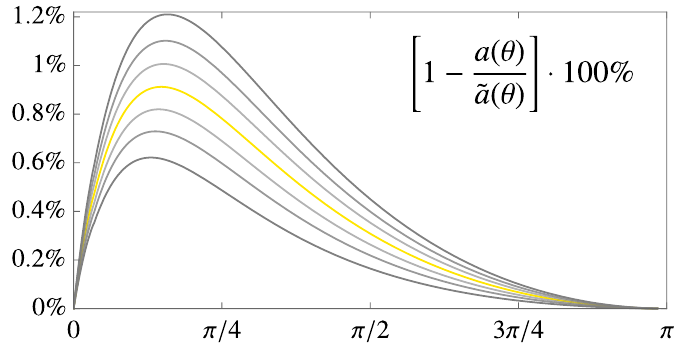
Figure 2 . We plot 1 − a ( θ ) / ˜ a ( θ ) where a ( θ ) is the exact corner function and ˜ a ( θ ) the trial function defined in eq. (5.98) for Einstein gravity (yellow) and ECG for different values of µ (from top to bottom: µ = +0 . 00312 , +0 . 002 , +0 . 001 , − 0 . 001 , − 0 . 002 , − 0 . 00322 ). The disagreement between both functions is always smaller than ∼ 1 . 2% throughout the whole range of values of the open- ing